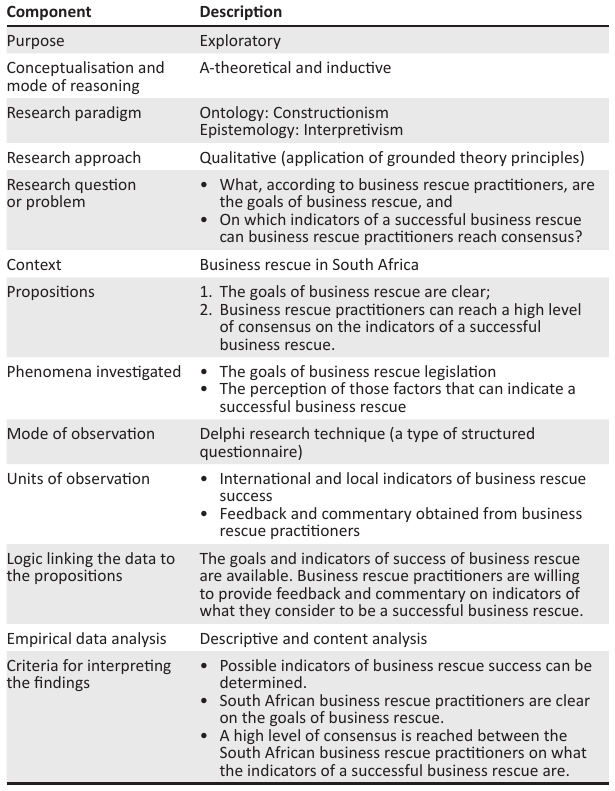
TABLE 1: Research design